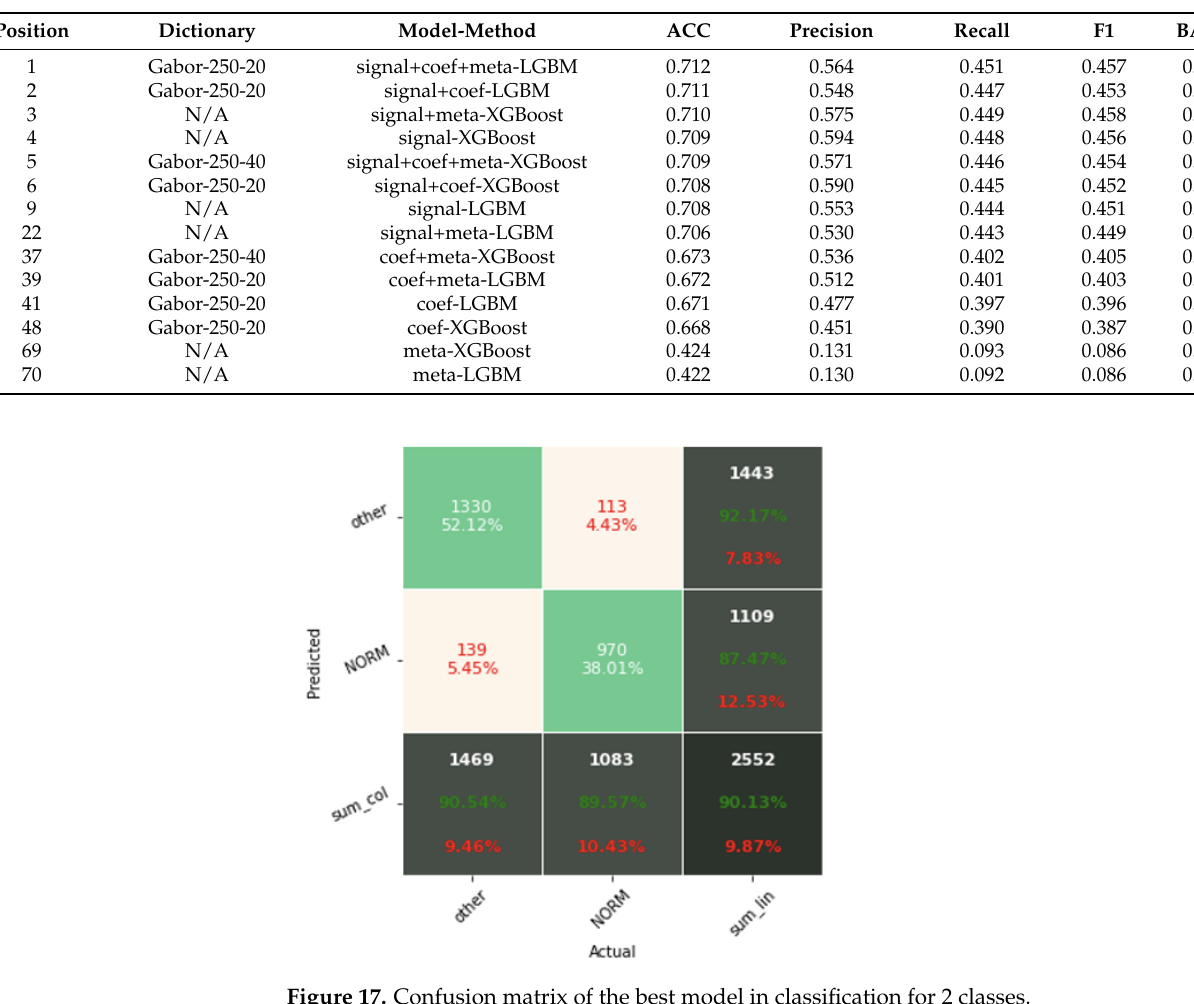
Table 8. Summary of average metrics scores for each data model, class size = 15.